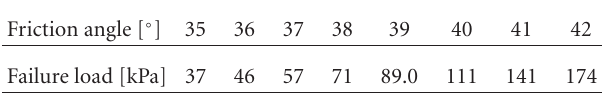
Table 6: Results from linear Mohr-Coulomb